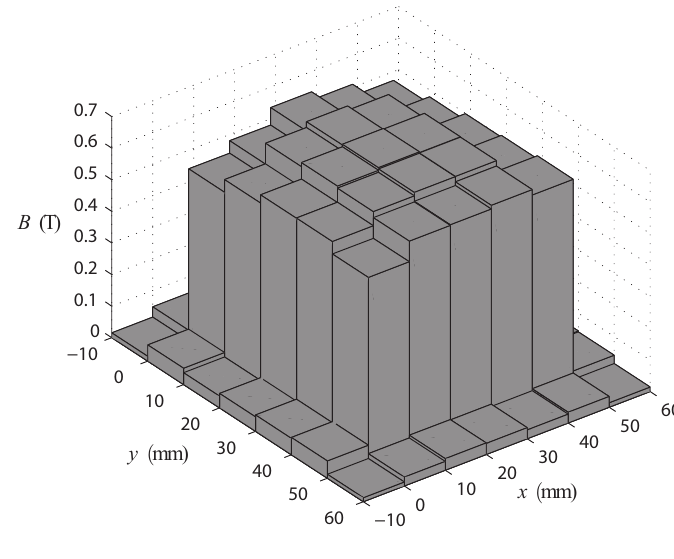
Figure 8. Magnetic flux density distribution in the airgap